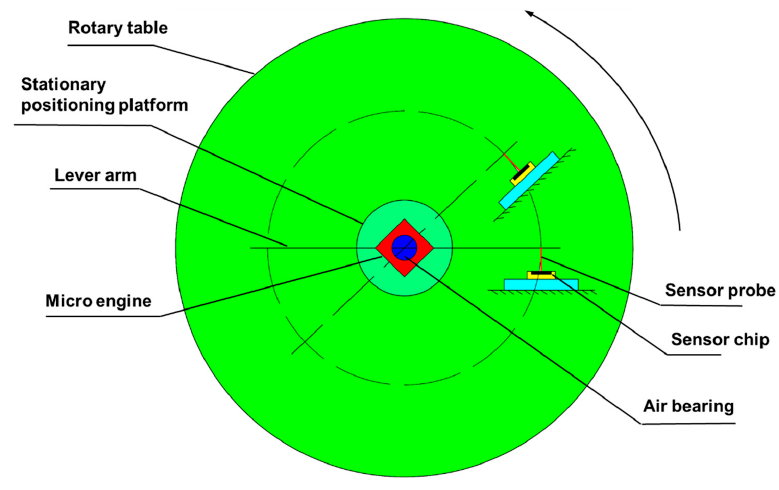
Figure 1. Schematic of the proposed measurement system.